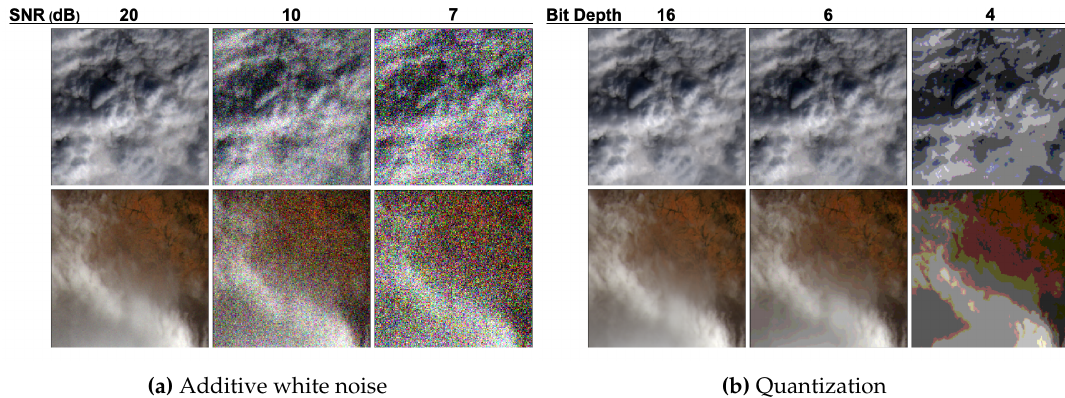
Figure 4. Examples of the effect of white noise and quantization throughout the range of levels applied to the Biome dataset for the validation in Section 5.5. For white noise, an SNR of 7 dB represents a significant distortion of the data, leading to most small features being over-powered by the white noise. Quantization also leads to a loss of textural information, acting to smooth large areas with similar intensities.